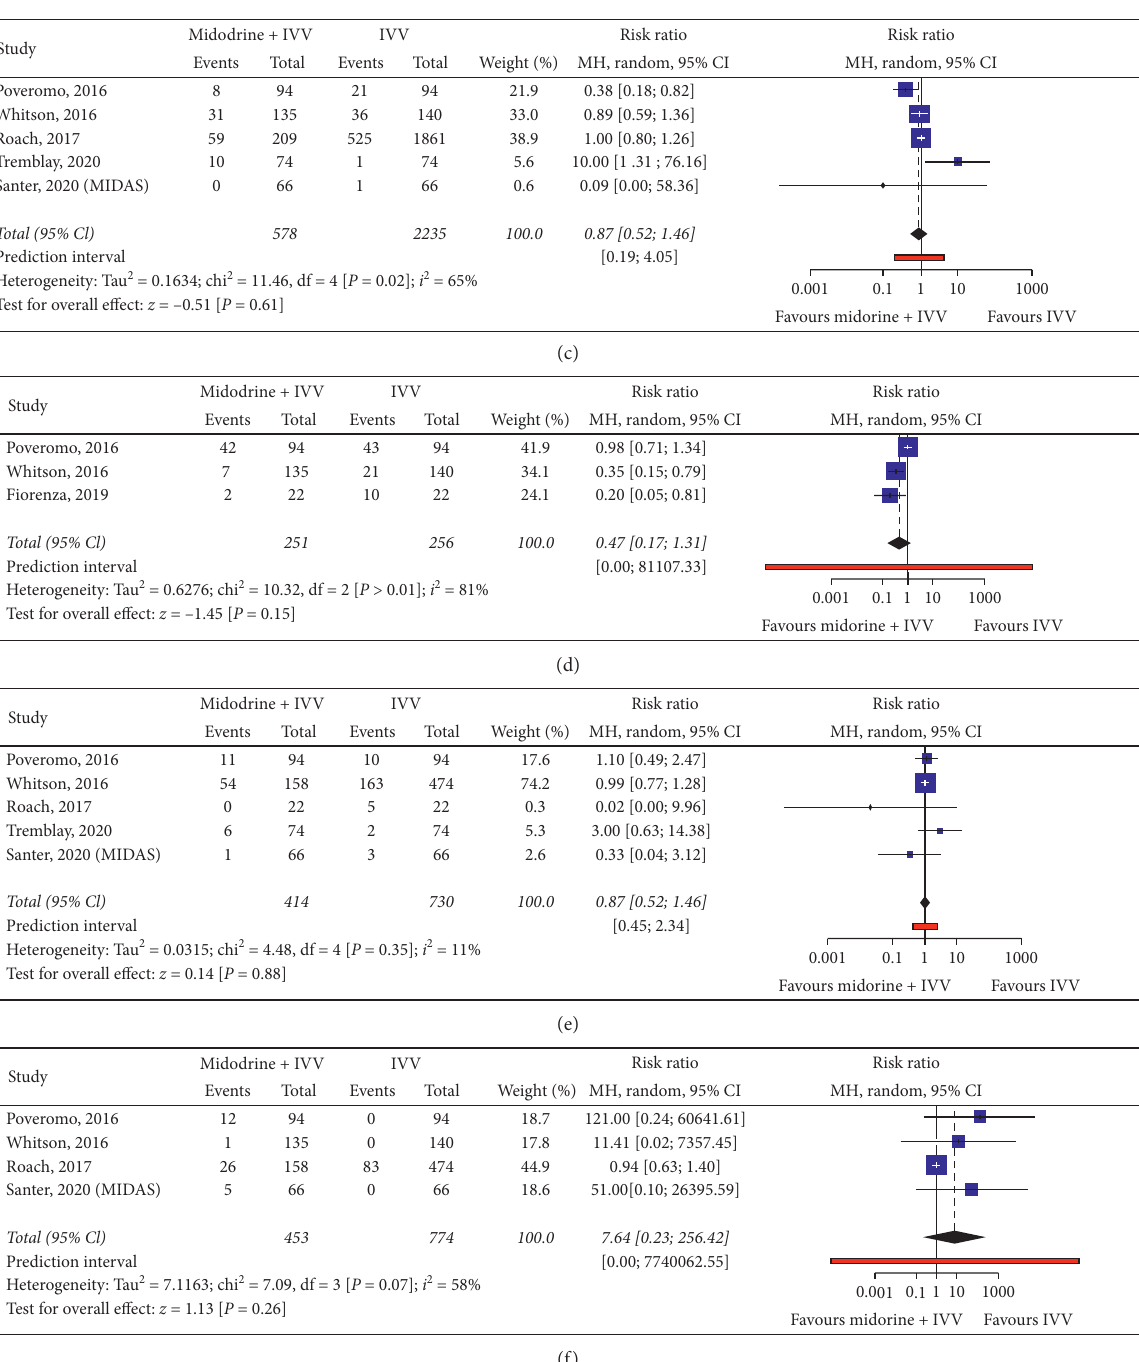
Figure 2: (a) Forest plot of mean duration of ICU length of stay. (b) Forest plot of mean duration of hospital length of stay. (c) Forest plot of in-hospital mortality. (d) Forest plot of intravenous vasopressors reinstitutions. (e) Forest plot of ICU readmission. (f) Forest plot of